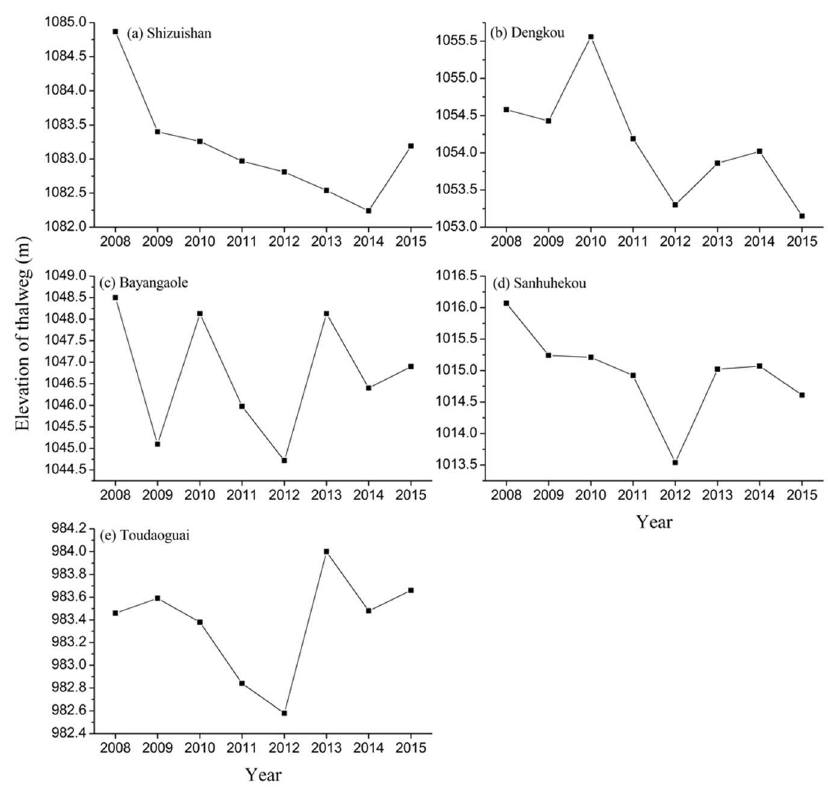
Figure 7. Variation of the thalweg’s elevation at different gauging stations before each ice jam flooding season: ( a ) Shizuishan station; ( b ) Dengkou station; ( c ) Bayangaole station; ( d ) Sanhuhekou station; and ( e ) Toudaoguai station.